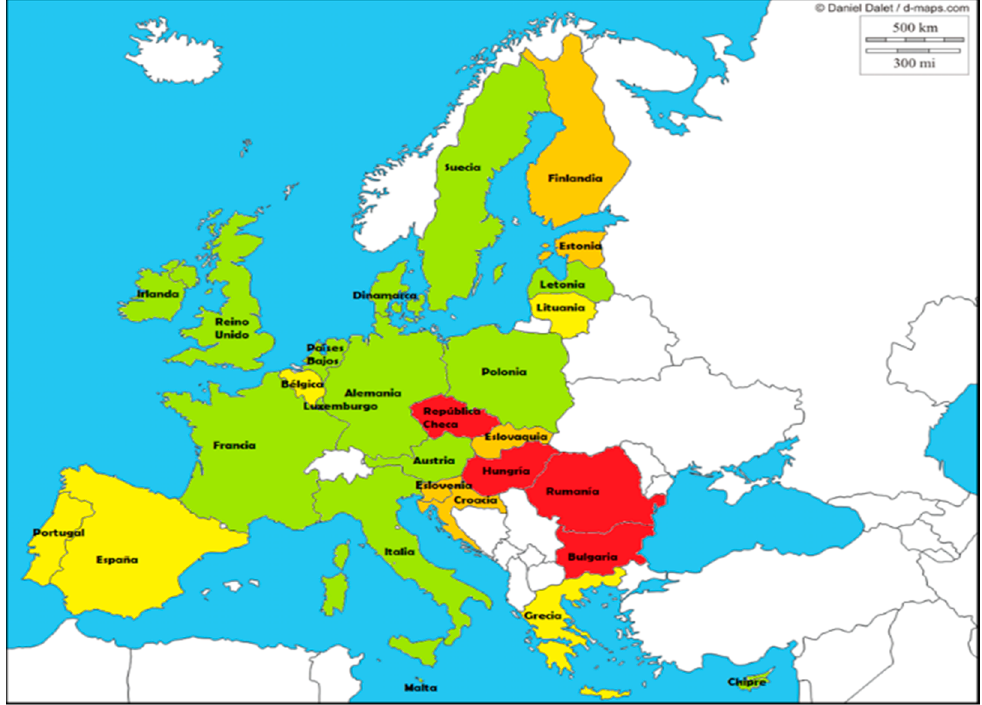
Figure 4. Representation of the 28 countries with one color according to their environmental efficiency obtained with the DEA Method 1. Source: own